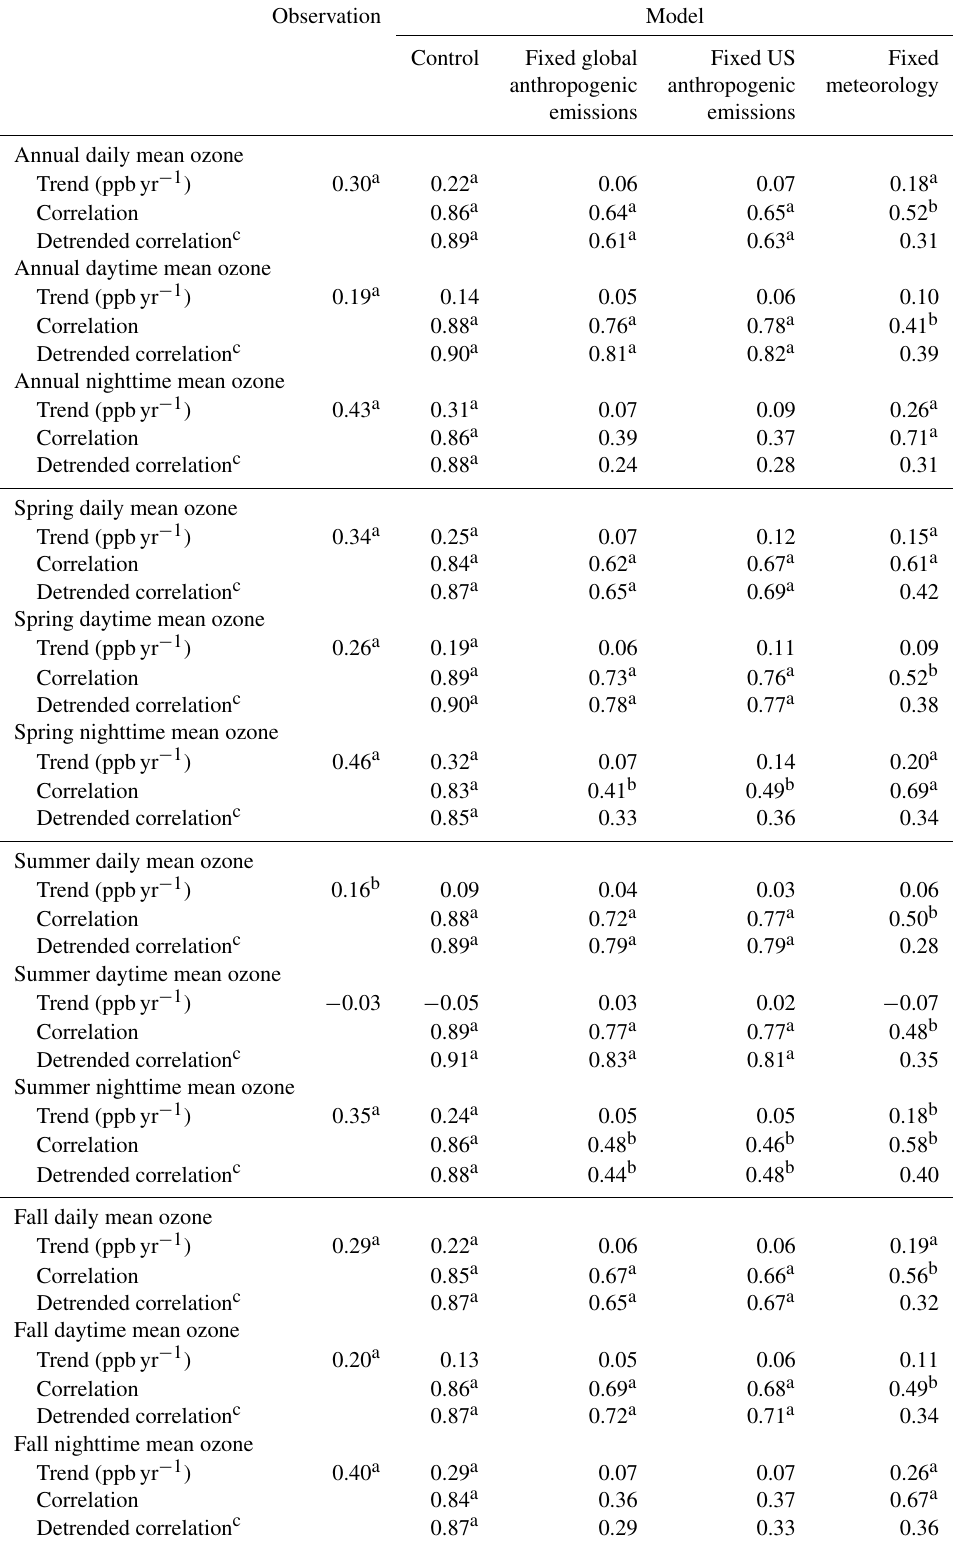
Table 5. Interannual variability of observed and modeled ozone during 2004–2012 and their